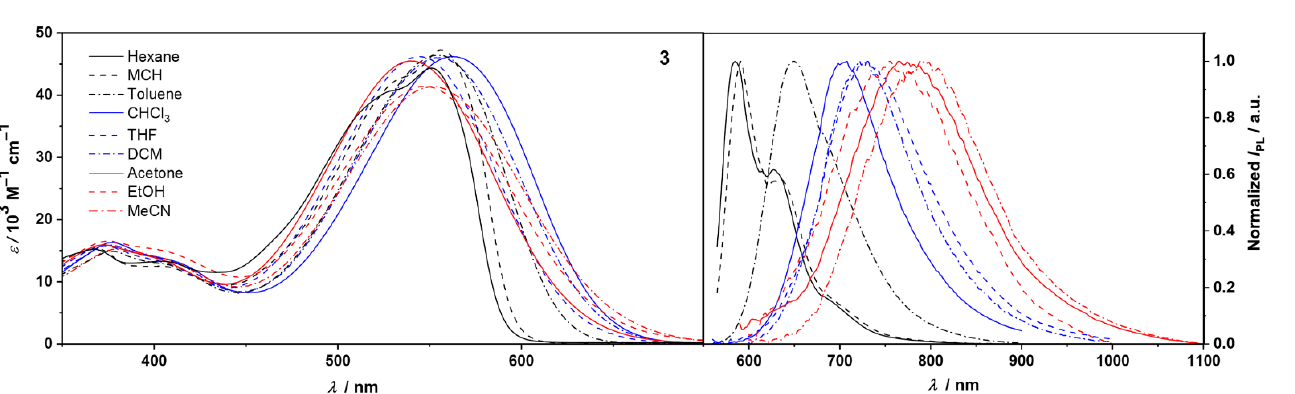
Figure 3. UV/Vis absorption spectra of 2 in solvents of varied polarity measured at c = 10 − 5 M–10 − 6 M ( left ). Fluorescence spectra in solvents of varied polarity (colors according to relative permittivity ε r : black lines for ε r < 3; blue lines for 3 < ε r < 10; red lines for ε r > 10) determined by the optical dilution method (OD < 0.05) ( right ).